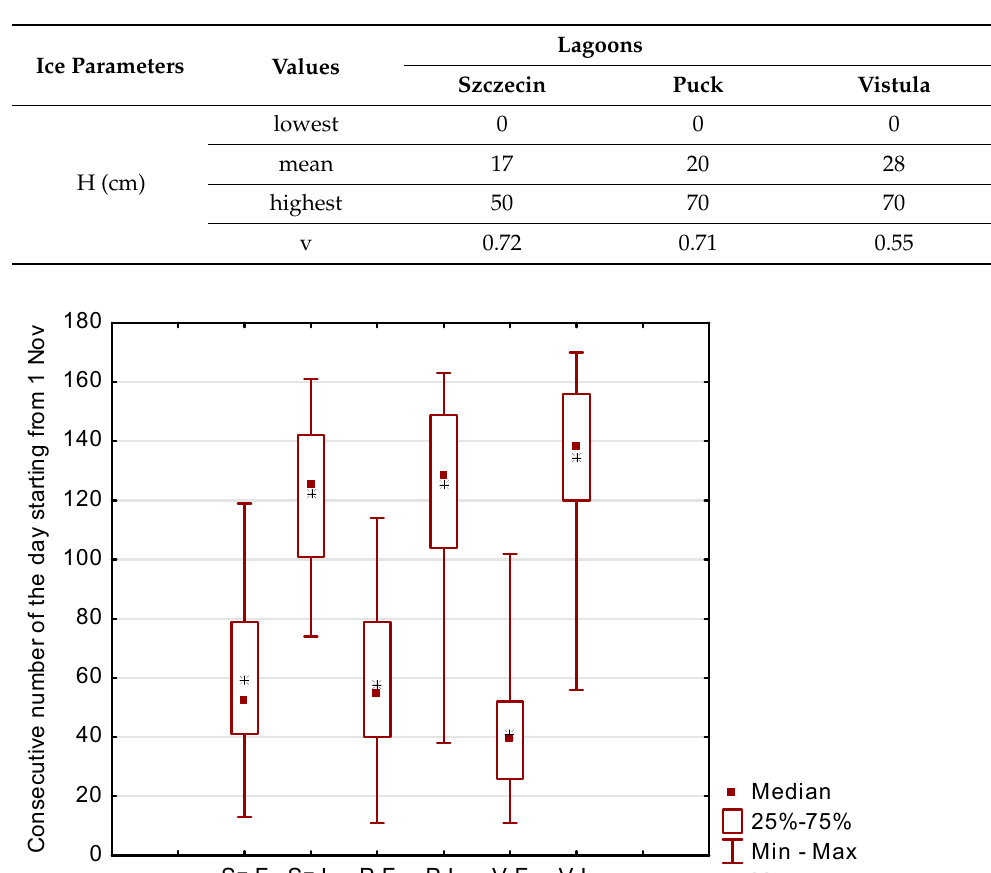
Figure 2. Box and whisker plots, presenting descriptive measures for first ice (F) and last ice (L) on Szczecin Lagoon (Sz–F and Sz–L, respectively), Puck Lagoon (P–F and P–L, respectively), and Vistula Lagoon (V–F and V–L, respectively) through the period 1950/51–2019/20. Boxes indicate the positions of the lower and upper quartile, and whiskers represent the maximum and minimum values of ice parameters. Consecutive day numbers (with 1 Nov as day 1) are given instead of dates.